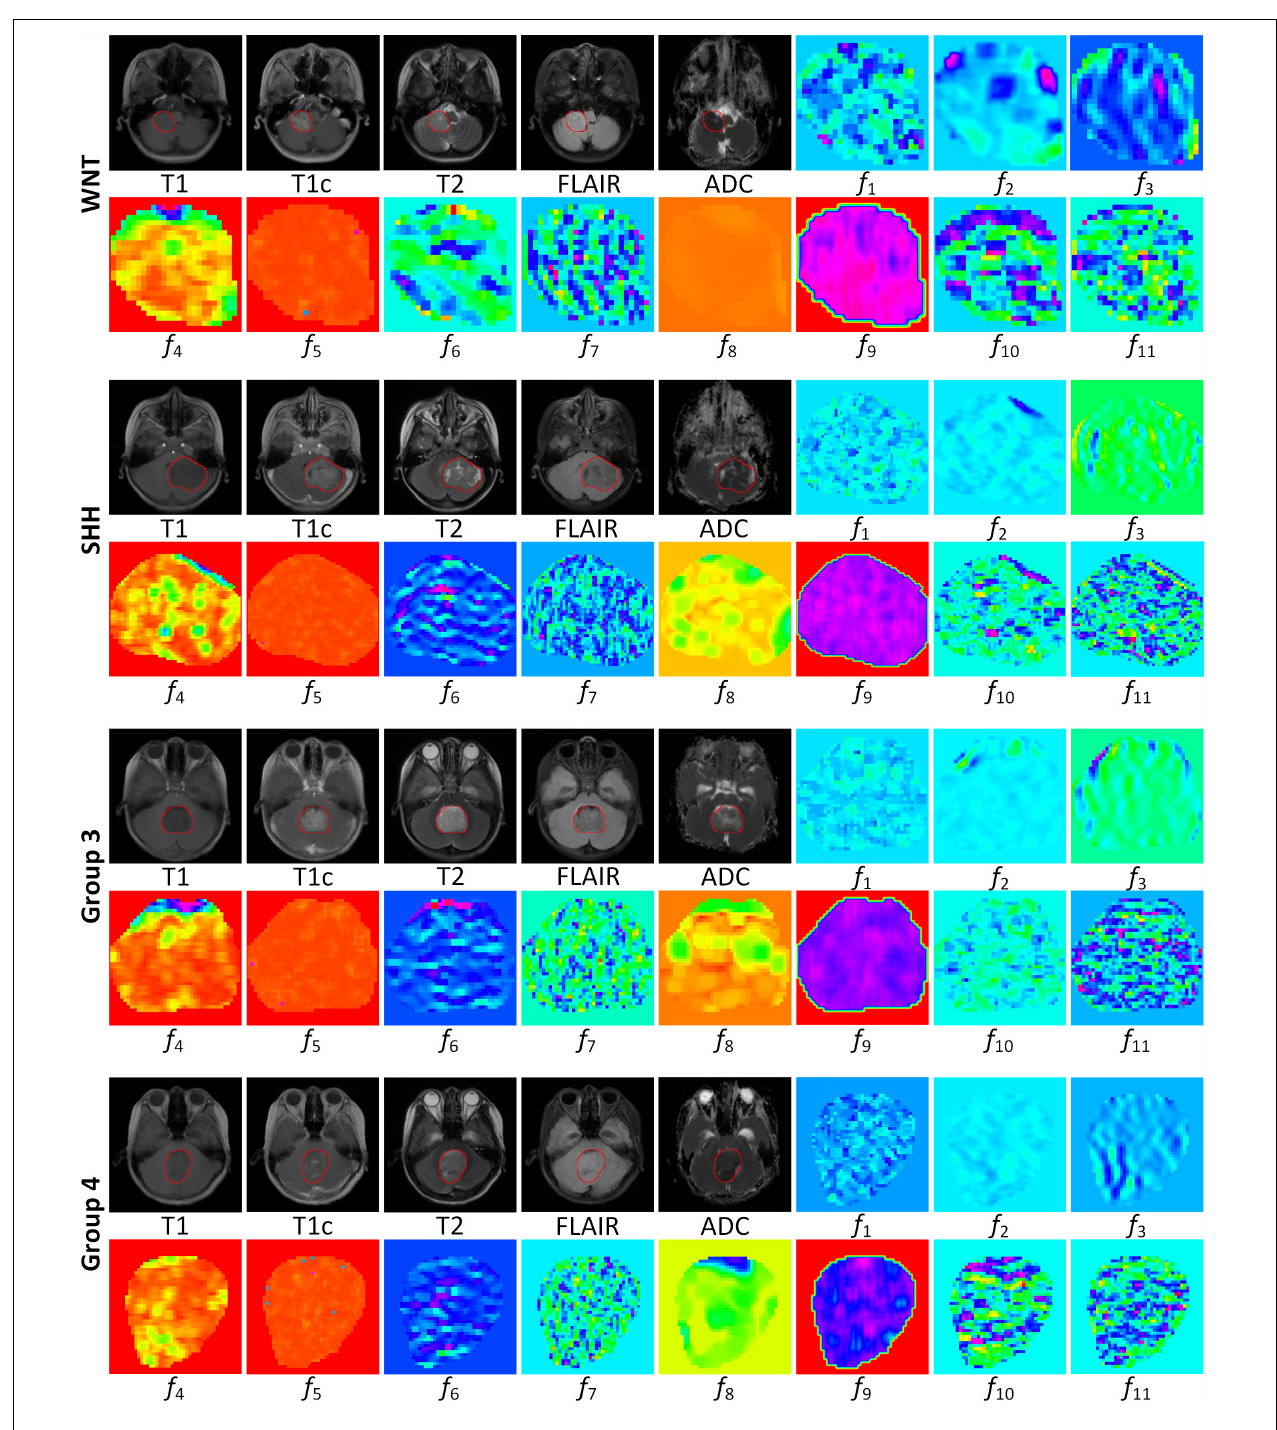
FIGURE 3 | MR images and corresponding feature maps of the selected 11 features for a wingless patient, a sonic hedgehog patient, a group 3 patient, and a group 4 patient. The delineated tumor contour was overlapped on the MR images. The radiomics features f 1 – f 11 are defined in Table 2 . The feature maps visualized the intratumoral variations of the image patterns, revealing the association of the radiomics features with the molecular subgroups.